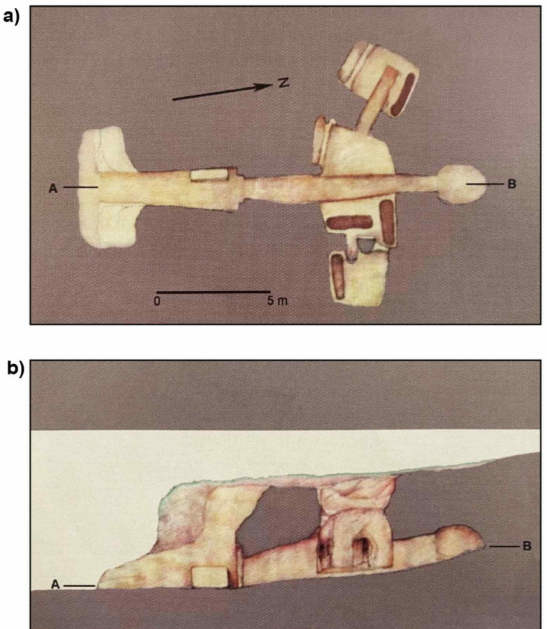
Figure 2. Schematic tomb structure. ( a ) Plan and ( b ) cross-section view of one of the rock-cut chamber tombs in Vigna la Piazza (VLP7) showing the typical burial morphology. Adapted from